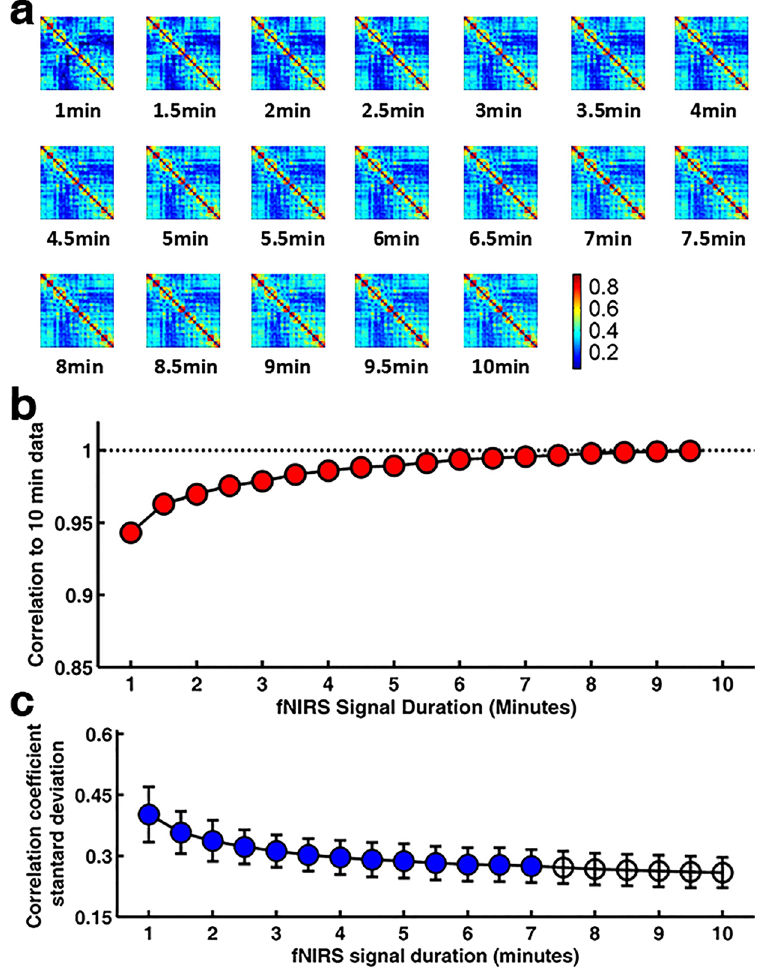
Figure 2. Effect of the fNIRS signal acquisition duration on the accuracy and stability of the spatial FC pattern. ( a ) The FC maps calculated by Pearson correlation for fNIRS signal acquisition durations ranging from 1.0 to 10 min with 30-sec bins. Visually, the spatial patterns of these FC maps exhibited high similarity across variable data collection lengths. ( b ) Accuracy curve. The plots of the correlation strength calculated for the spatial patterns of FC maps (transferred to z score before calculation) between short and long (10.0 min) signal durations. The red-filled circles indicate significant correlation of the spatial FC maps associated with a given fNIRS signal acquisition duration with the FC map when computed using 10.0 min of fNIRS data. The analysis revealed significant ( P < 0.001) and strong correlations for all acquisition durations, indicating almost immediate accuracy of the FC maps. ( c ) Stability curve. The plots of the correlation coefficient associated with the standard deviation (mean ± SD) plotted according to the duration of the fNIRS signal acquisition (1.0~10.0 min in 30-sec bins). The blue-filled circles indicate a significant difference in the magnitude of the computed value associated with a given fNIRS signal acquisition duration compared with the magnitude when computed using 10.0 min of fNIRS data. The magnitude of the correlation coefficient standard deviation decreased as the fNIRS signal acquisition duration increased, with little change in magnitude after approximately 7.0 min of data